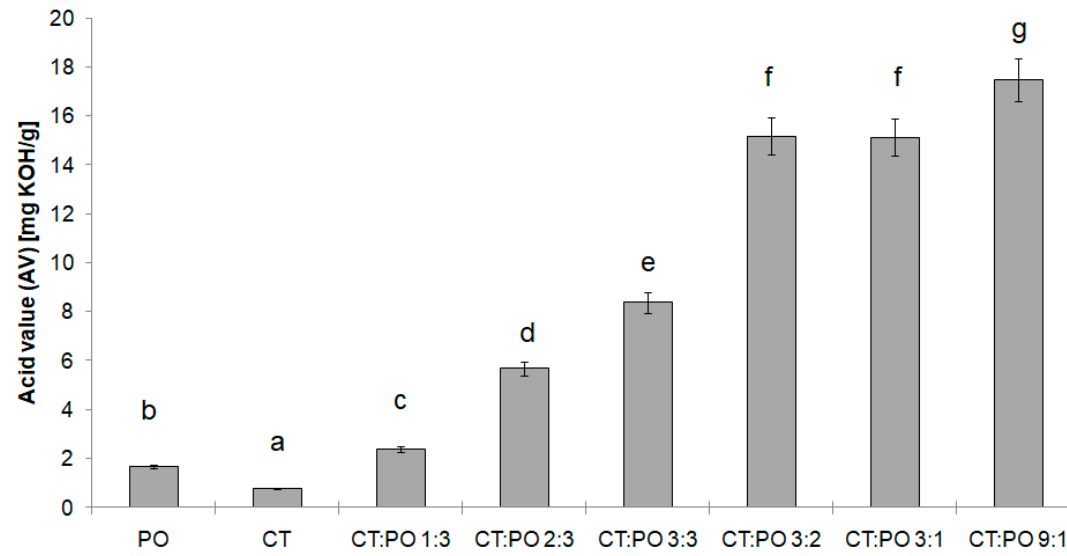
Figure 1. Acid value (AV) of the raw fats and interesterified fat blends. Different letters indicate statistically significant difference ( p <